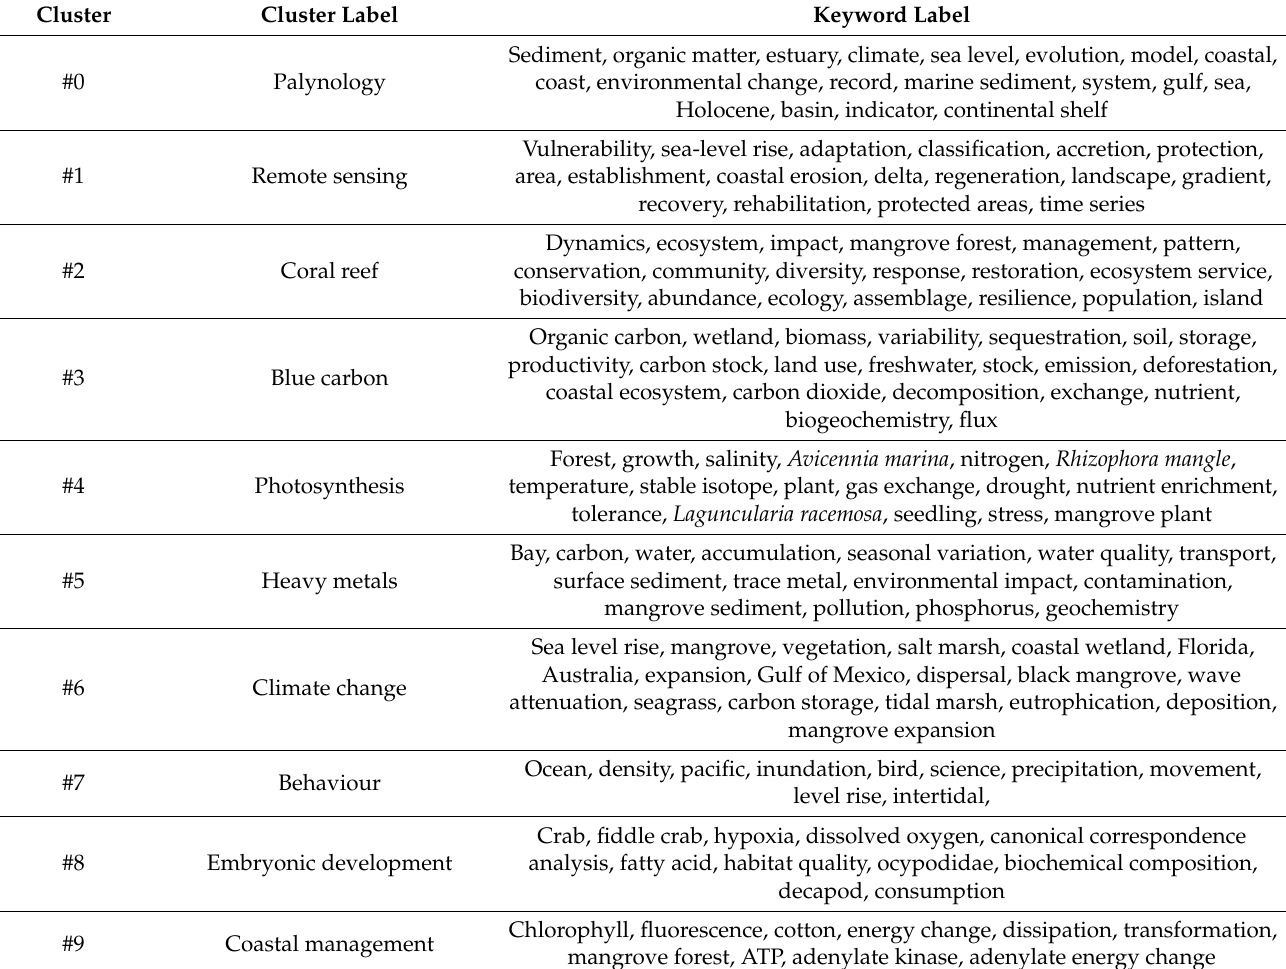
Table 8. Most frequent keyword label describing the cluster label for mangrove and climate change literature